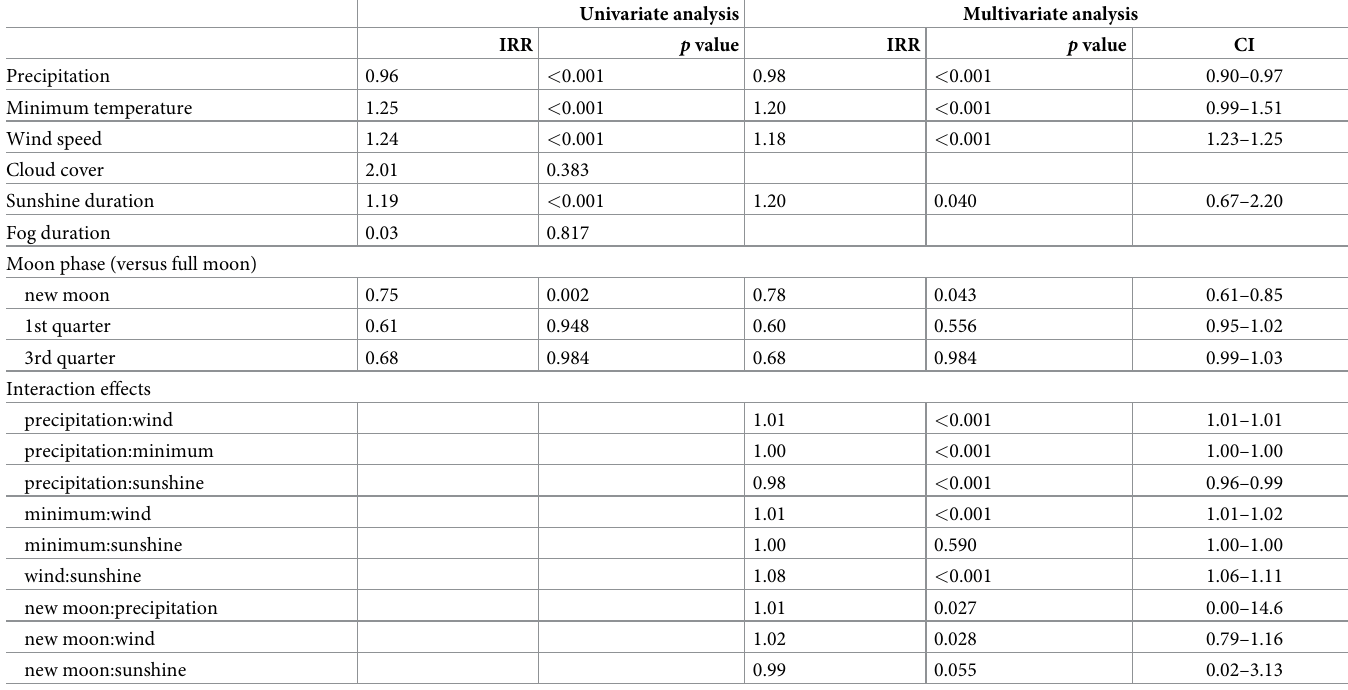
Table 3. Multivariate regression analysis of relationships between weather factors and moon phase with fall injuries in rural